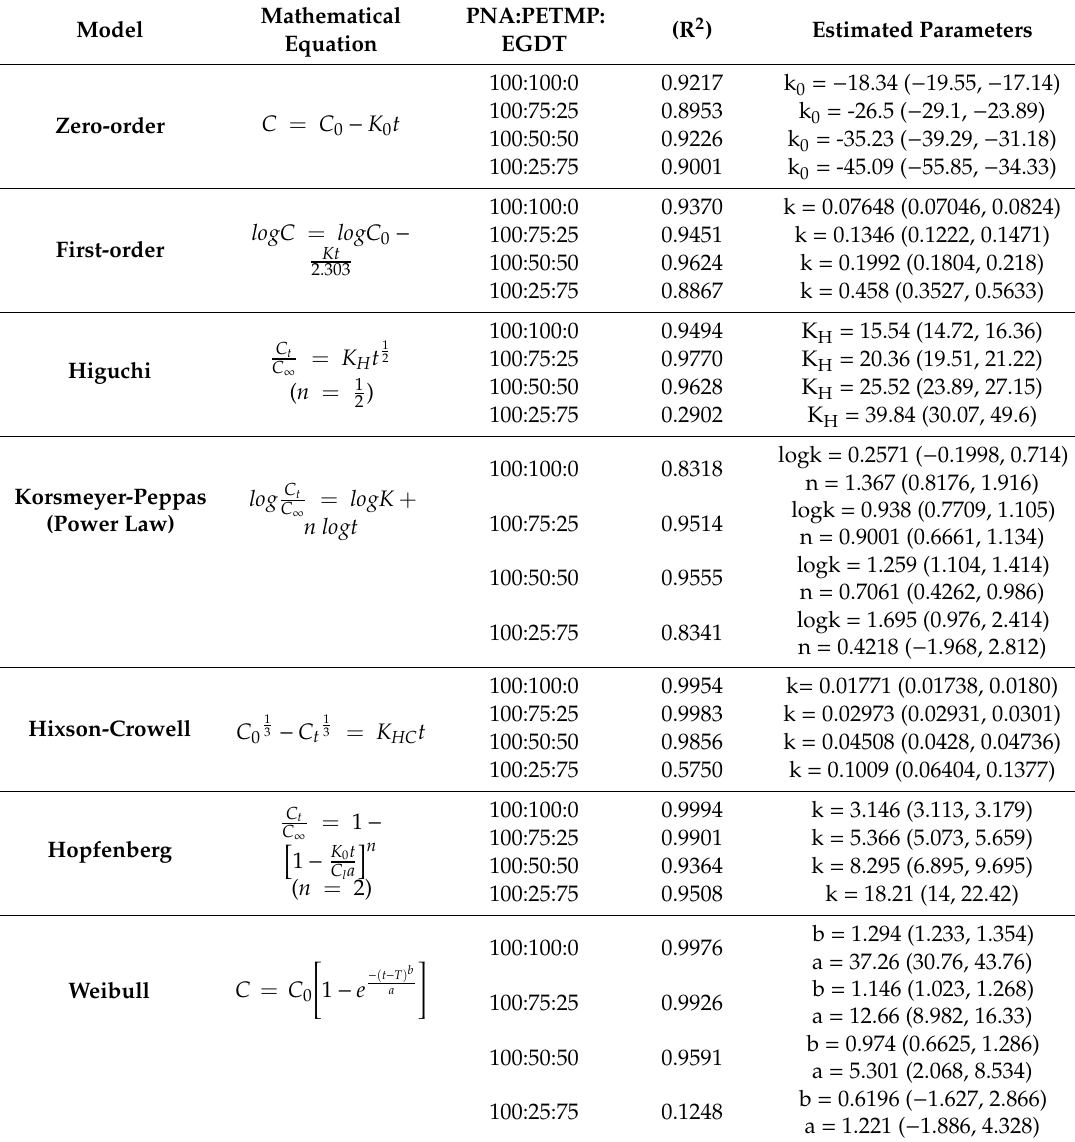
Table 2. Release kinetic models fitting for a cylindrical tablet. The models with their equations, mole ratios of monomers, R 2 , and derived parameters are shown in this